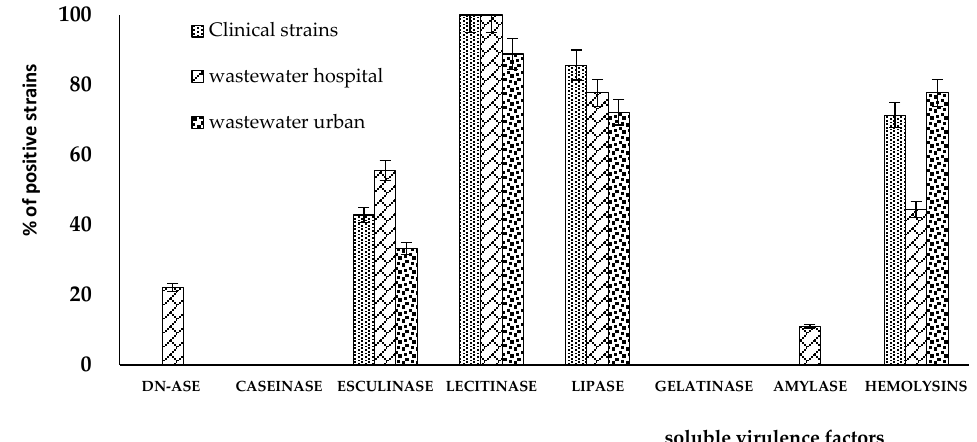
Figure 4. Graphic representation of the distribution of soluble virulence factors expressed by the P. aeruginosa strains. The graph represents the percentage (%) of positive strains for each of the evaluated virulence factor depending on their isolation source.